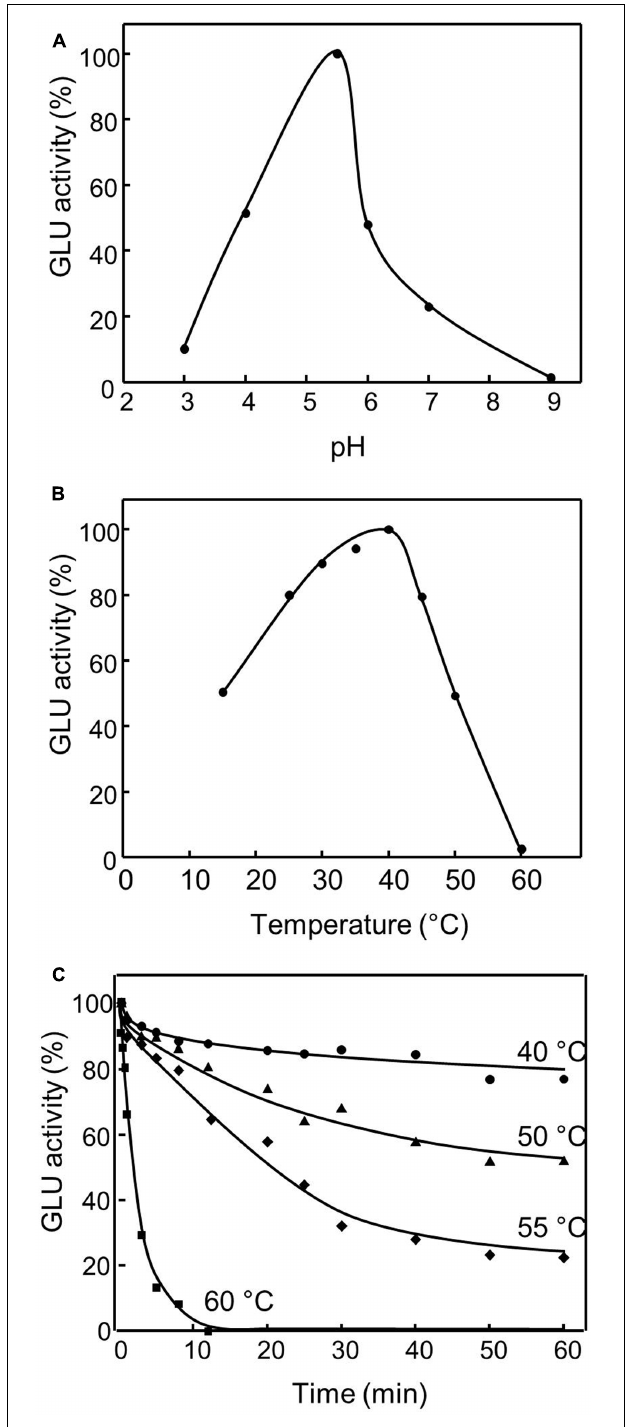
FIGURE 3 | Effect of pH (A) , temperature (B) , and thermal stability (C) on the purified recombinant OepGLU activity. The optimum pH was determined using sodium acetate, phosphate and borate buffers (50 mM) in the standard assay. The optimum temperature was determined using a temperature interval of 15–60 ◦ C in the standard assay. Thermal stability was determined under standard assay conditions after incubation of purified preparation at different temperatures for 60 min. 100% activity was 50.9 U/ml.